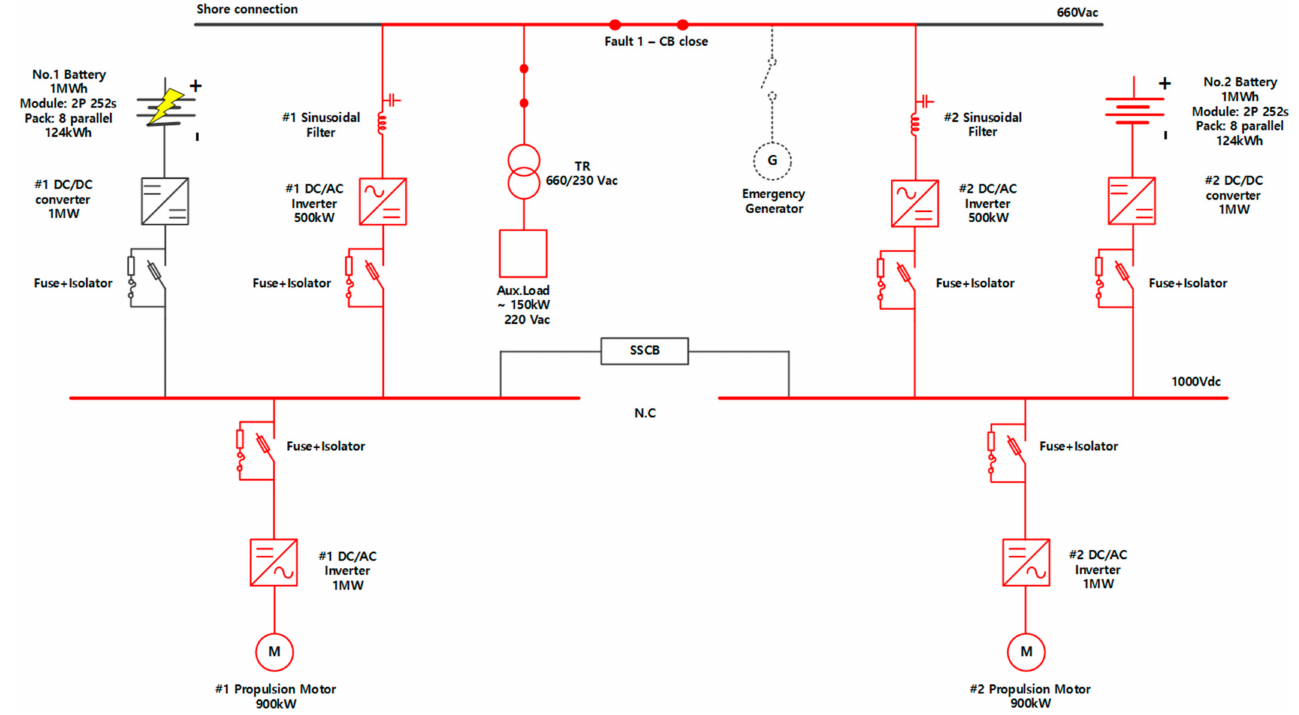
Figure 12. Schematic diagram of the discharge reflecting battery accident situation—Fault 1.